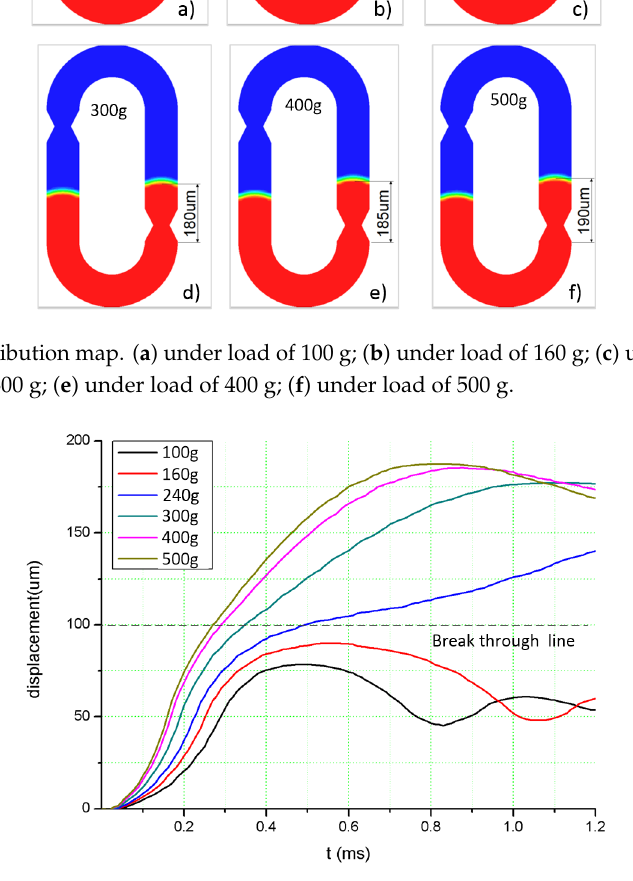
Figure 3. The distribution map. ( a ) under load of 100 g; ( b ) under load of 160 g; ( c ) under load of 240 g; ( d ) under load of 300 g; ( e ) under load of 400 g; ( f ) under load of 500 g.